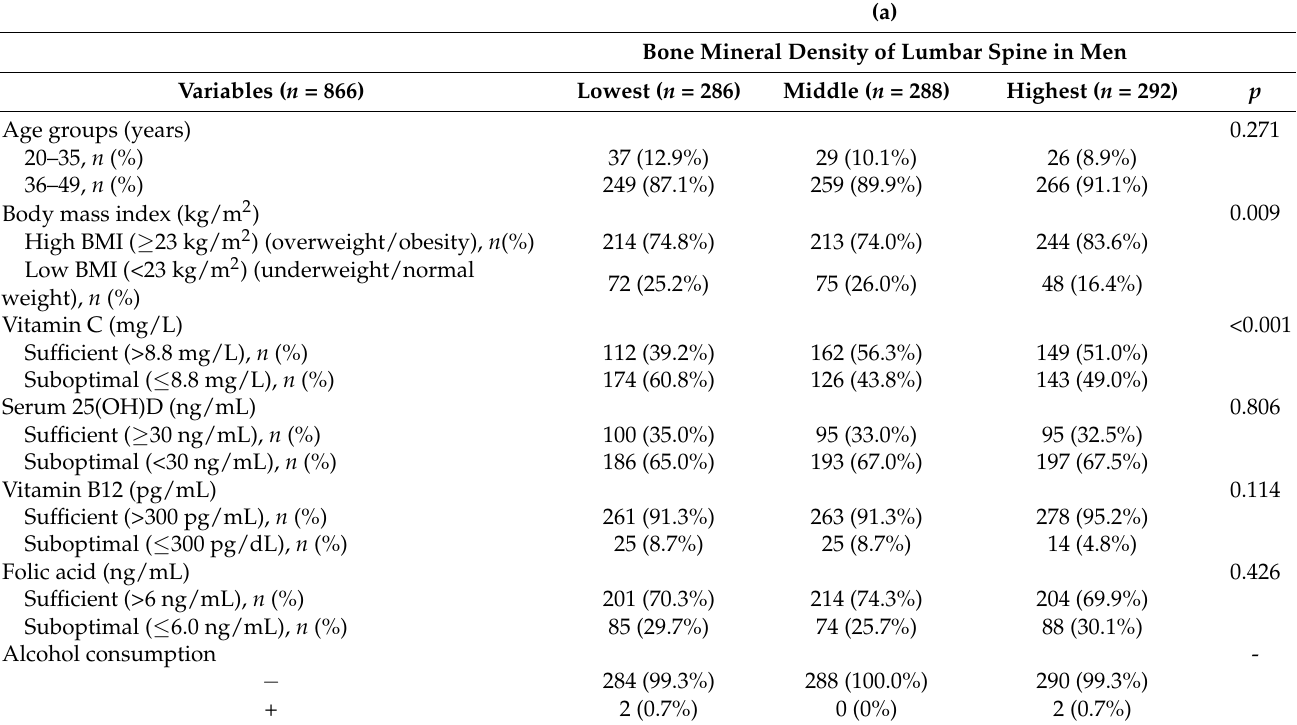
Table 3. ( a ) Comparison of age, BMI, and nutrients’ levels with tertiles of lumbar spine BMD in men. ( b ) Comparison of age, BMI, and nutrients’ levels with tertiles of lumbar spine BMD in